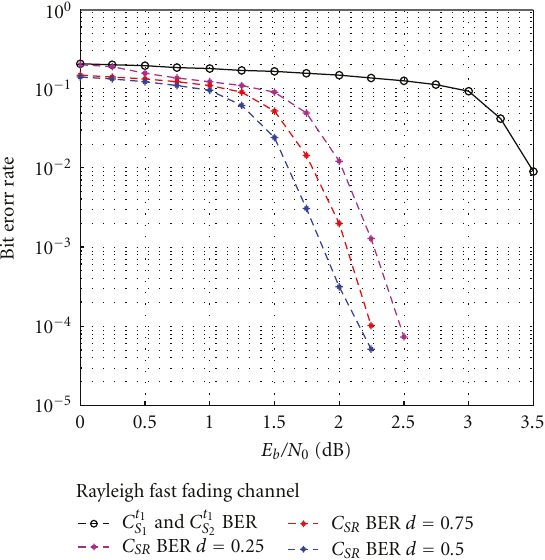
Figure 13: The BER performance under the AWGN channel with di ff erent settings of d , the distance between Source and Relay.